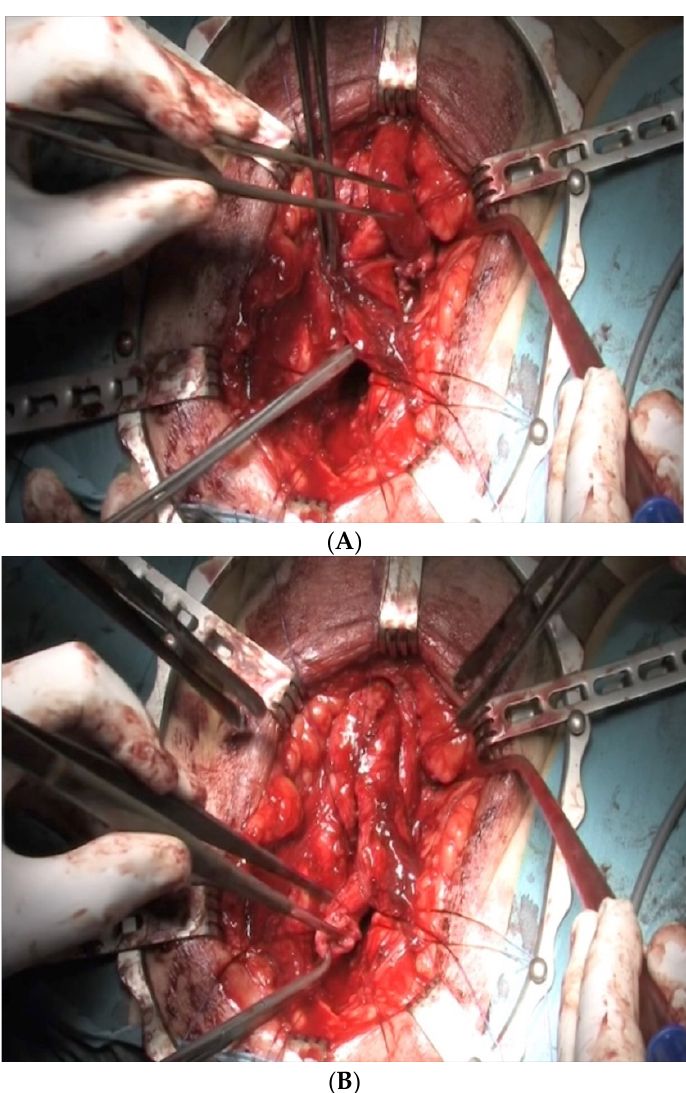
Figure 3. Inferior wedge pubectomy.